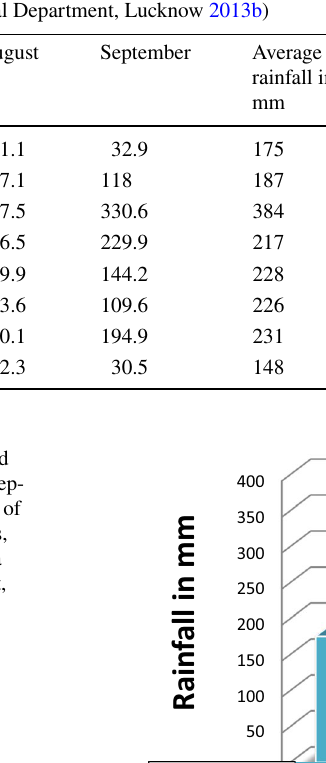
Table 1 Average rainfall trend in monsoon period (July–September)